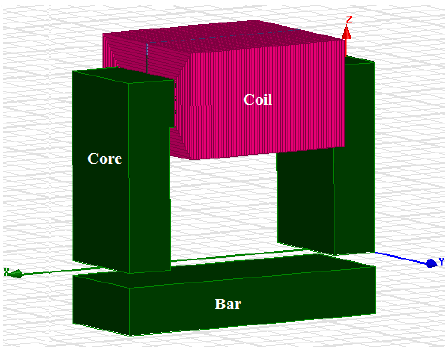
Figure 5: Electromagnet structure in 3D Maxwell Software